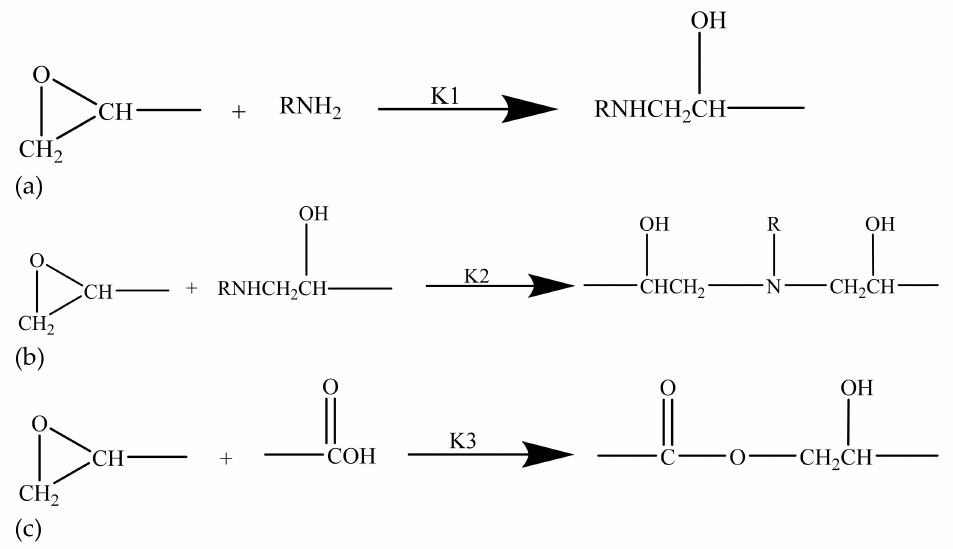
Figure 1. The ring-opening reactions involved in polymerization of epoxy: ( a ) the ring-opening reaction of the epoxide group and the primary amine of hardener agent; ( b ) the ring-opening reaction of the epoxide group with the secondary amine formed in ( a ); ( c ) the self-catalyzed ring-opening reaction from the hydroxyl